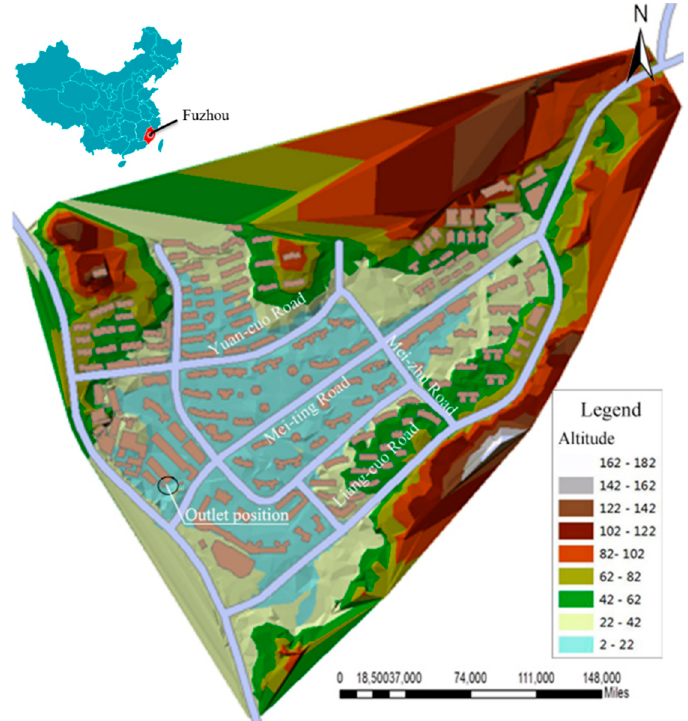
Figure 1. Regional pipe network and triangulated irregular network (TIN) model.